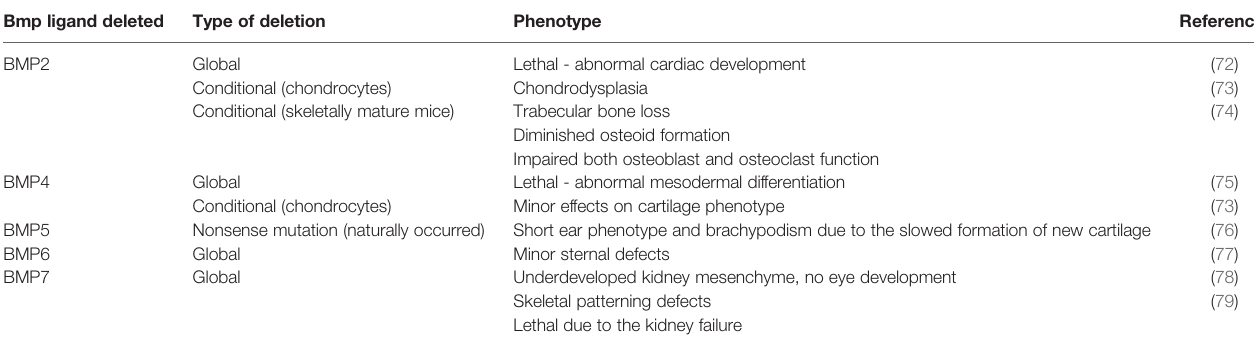
TABLE 1 | An overview of BMP knockout rodent